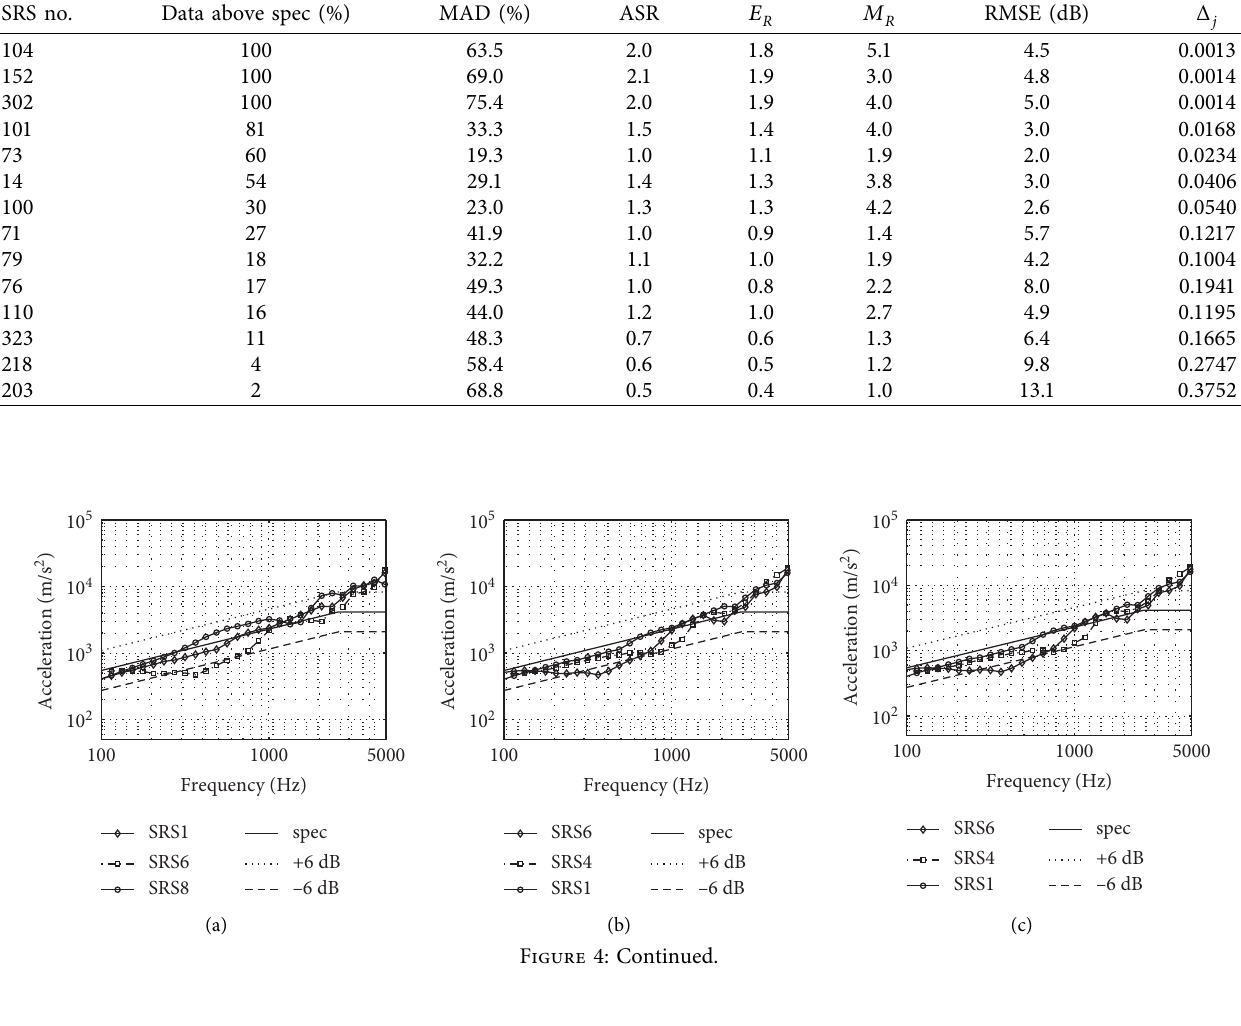
Table 4: Comparison of different methods for SRS database retrieval (database size � 324). SRS